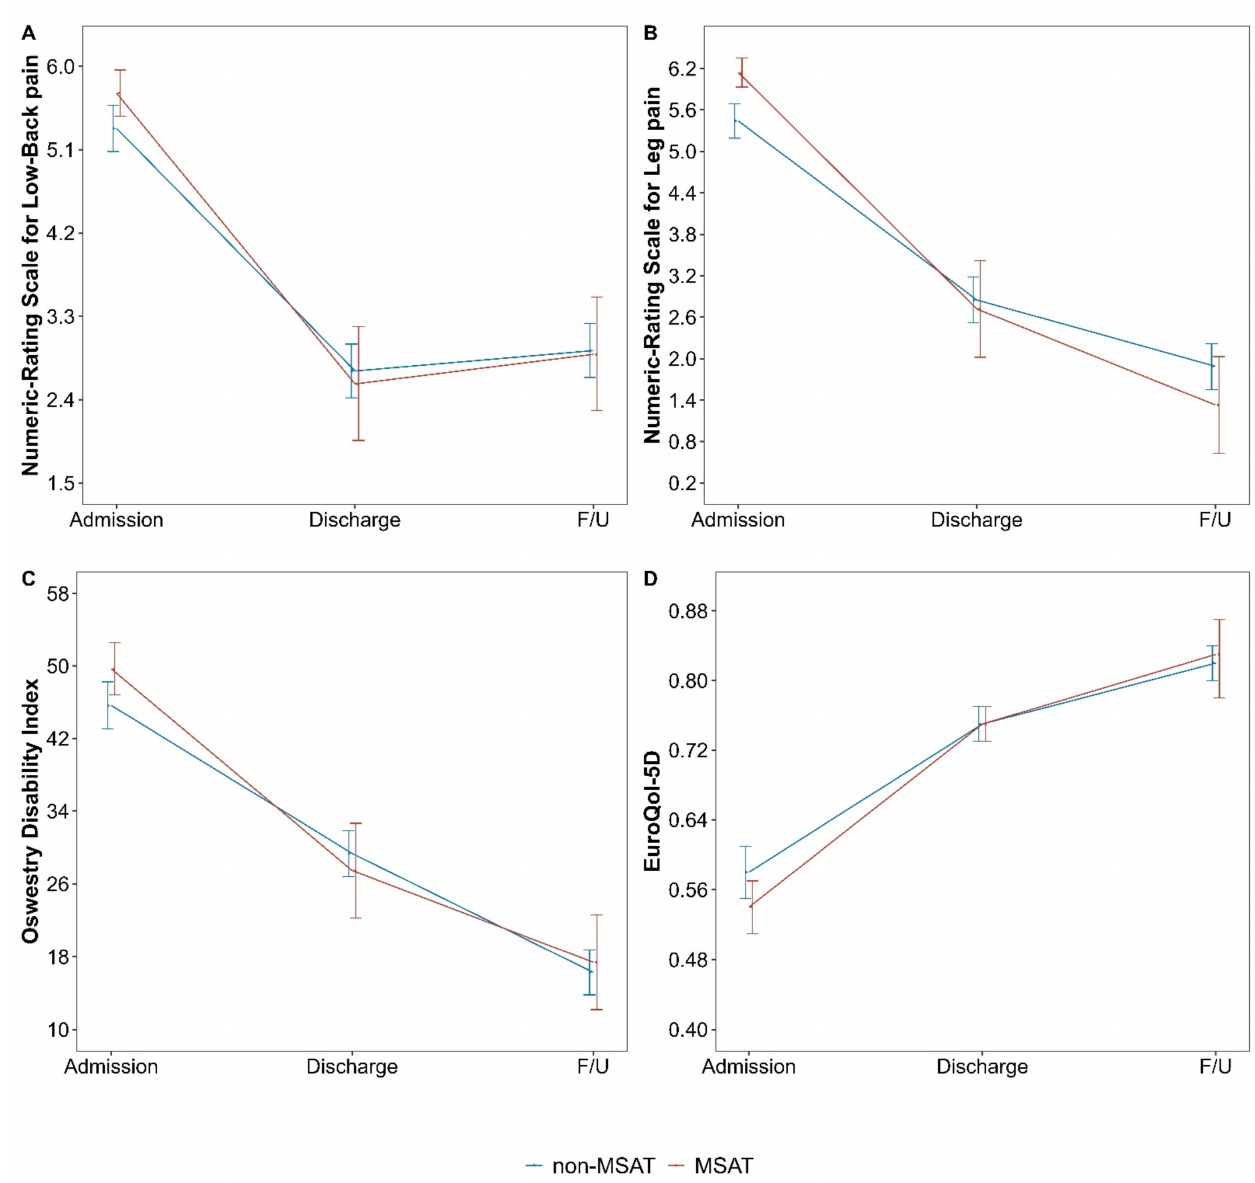
Figure 2. Changes in outcome at admission, discharge and follow-up in the MSAT and n-MSAT groups. Abbreviation: follow-up